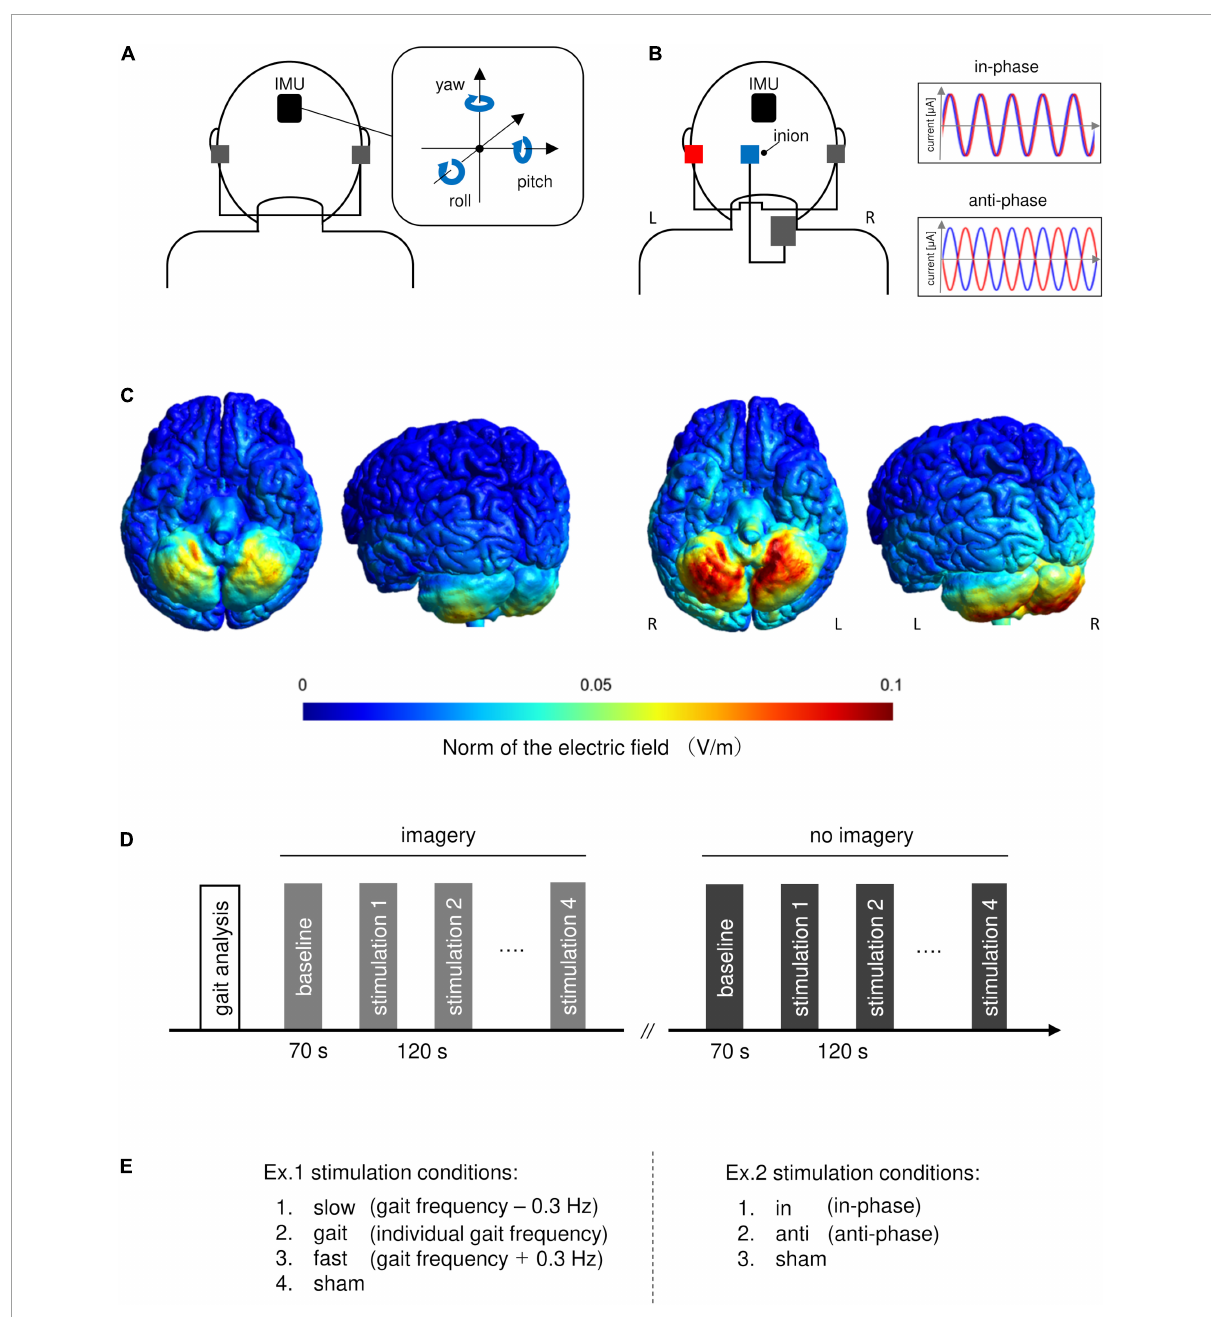
FIGURE1 Experimental design. (A) Placement of AC-GVS electrodes and the axes of the inertial measurement unit (IMU). The AC-GVS electrodes were placed on the mastoid processes. We analyzed periodic head movement via angular velocity. (B) Electrode placement in the combined stimulation condition. The tACS target electrode (blue square) was centered 3 cm left-lateral from the inion. The left AC-GVS (red) and tACS of the left cerebellum (blue) were applied in two conditions: in-phase (stimulation with 0 ◦ phase difference), and anti-phase (180 ◦ phase difference). (C) The vector Norm of the electrical fields by AC-GVS (left two panels) or combined stimulation (right two panels). (D) Time course of Experiment 1. Participants underwent the two sessions (imagery and no-imagery) after gait analysis. The periodic postural response was measured under four stimulation conditions and baseline in each session. (E) The stimulation conditions in Experiments 1 and 2. L, left; R,